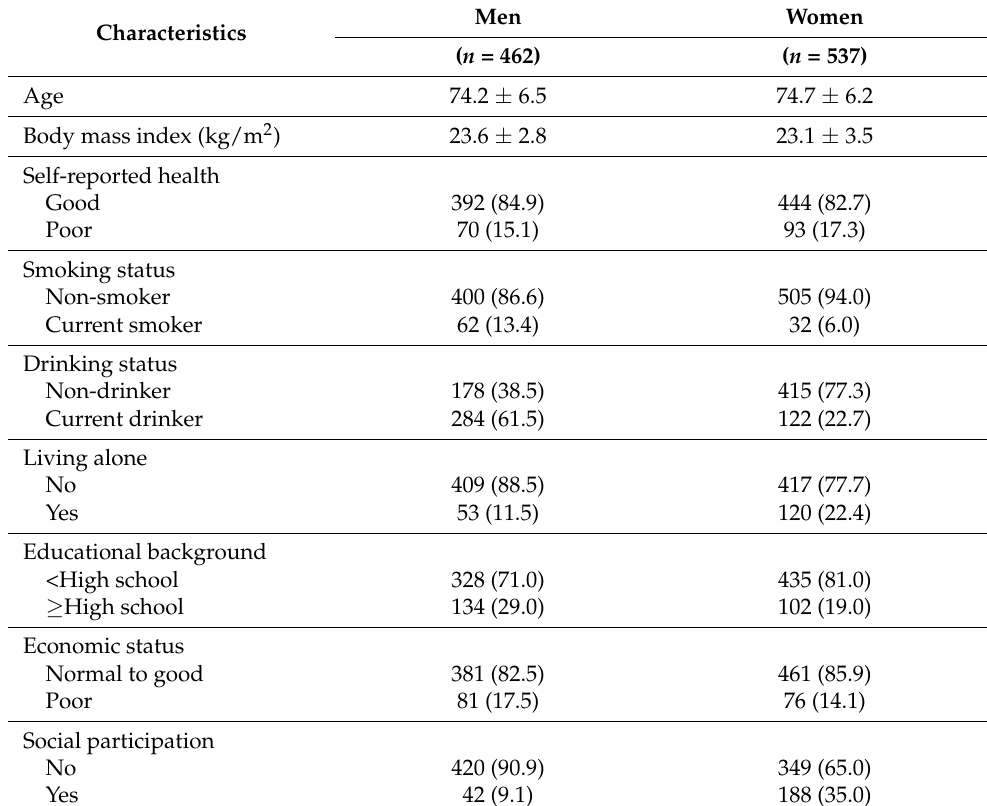
Table 1. Demographic and clinical characteristics of the participants in Eniwa, Hokkaido, Japan.